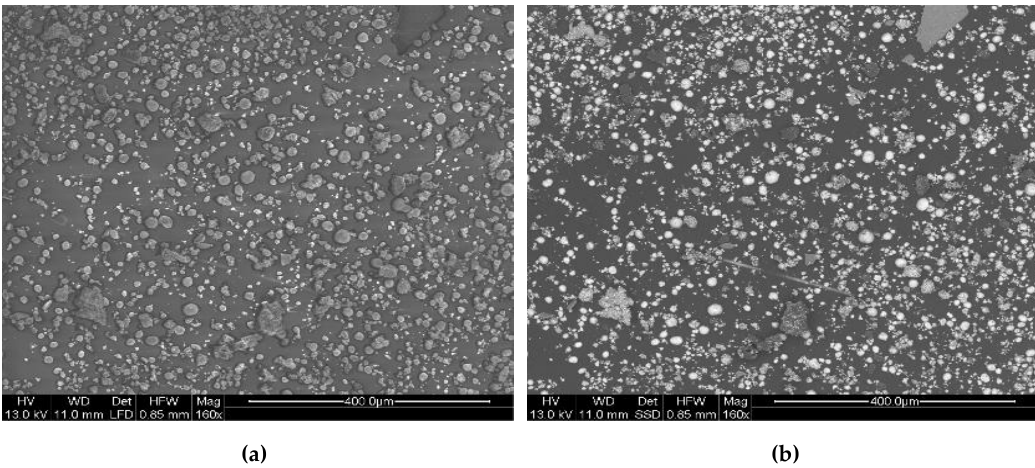
Figure 12. SEM images of particles assembled after the TR. ( a ) SE image shows the topographic contrast; ( b ) BSE measurement shows the material contrast of the same area of the sample. Particles were positioned on a carbon adhesive tape. Table 4. Average measured area (a) of particles and average number of particles produced from an automotive pouch cell (at 100% SOC) at overtemperature.